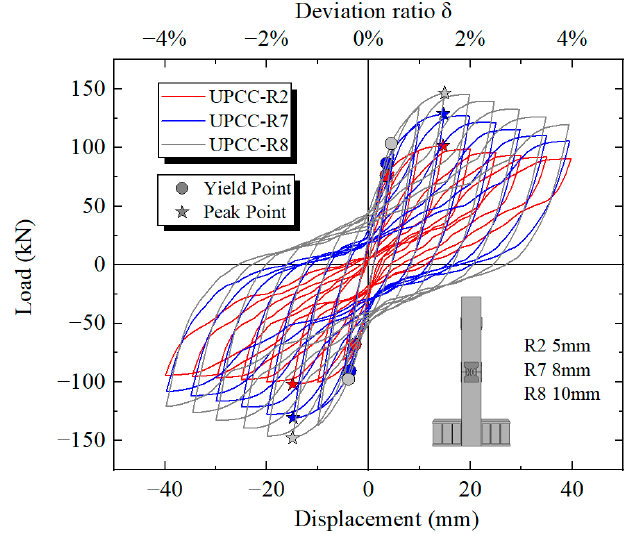
Figure 29. Hysteretic curves under different thicknesses of EREDL.